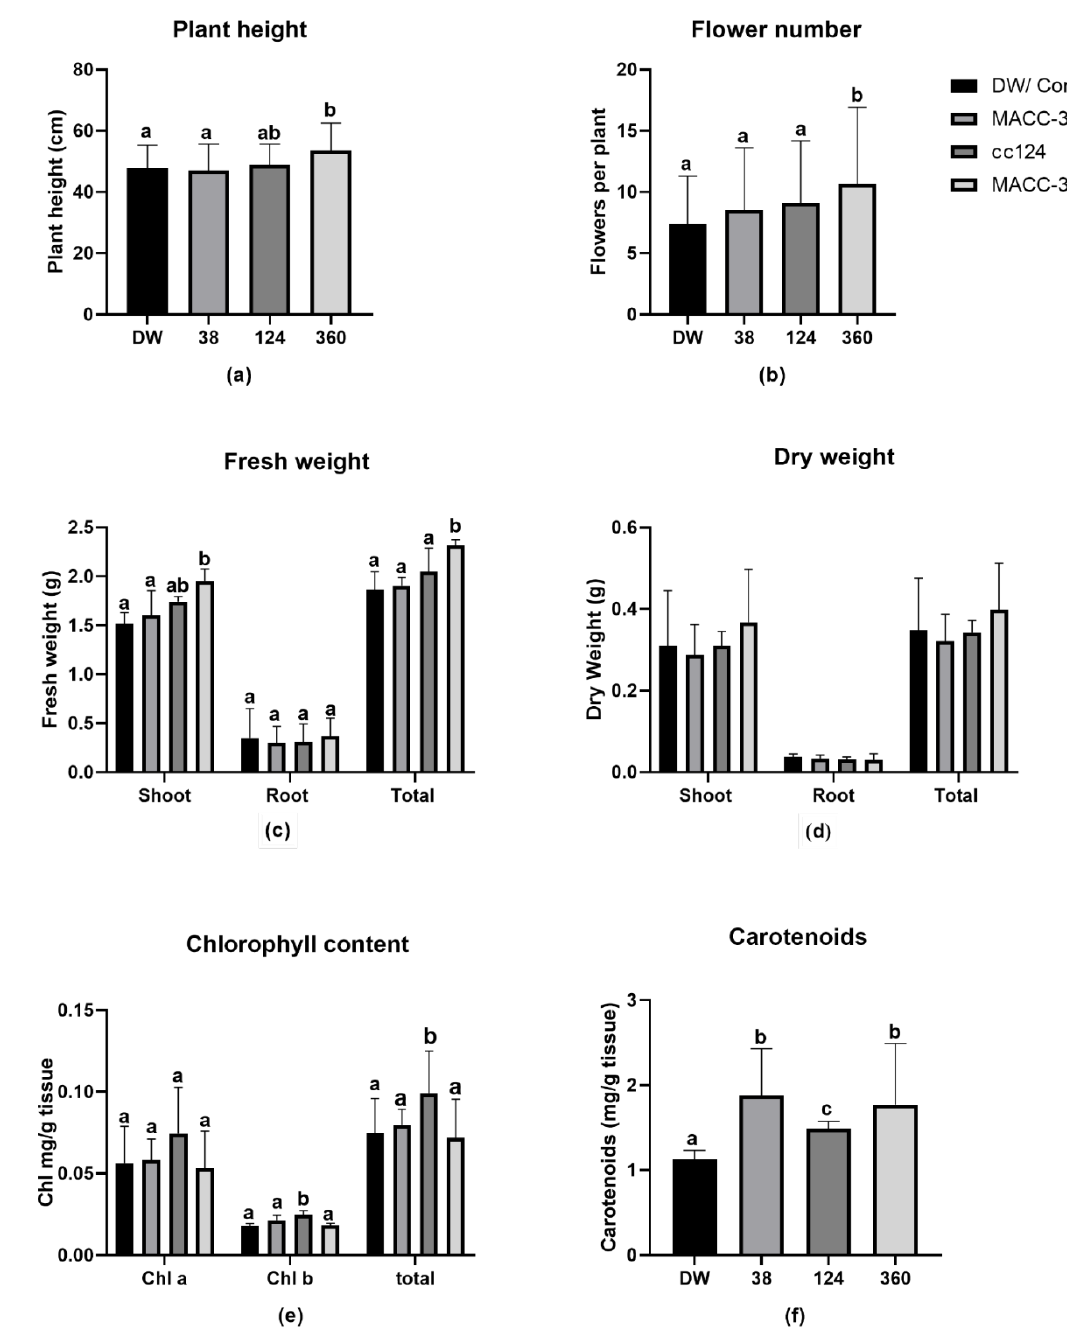
Figure 6. Effects of microalgae applications on plants (50-day-old plants); ( a ) plant height; ( b ) flower number; ( c ) fresh weight; ( d ) dry weight; ( e ) chlorophyll; ( f ) carotenoids. Data represent means and standard errors (error bars) of 10 biological replicates per experiment. Different letters on bars indicate significant differences between groups ( p < 0.05), according to Tukey’s test. One-way ANOVA was used for all parameters.